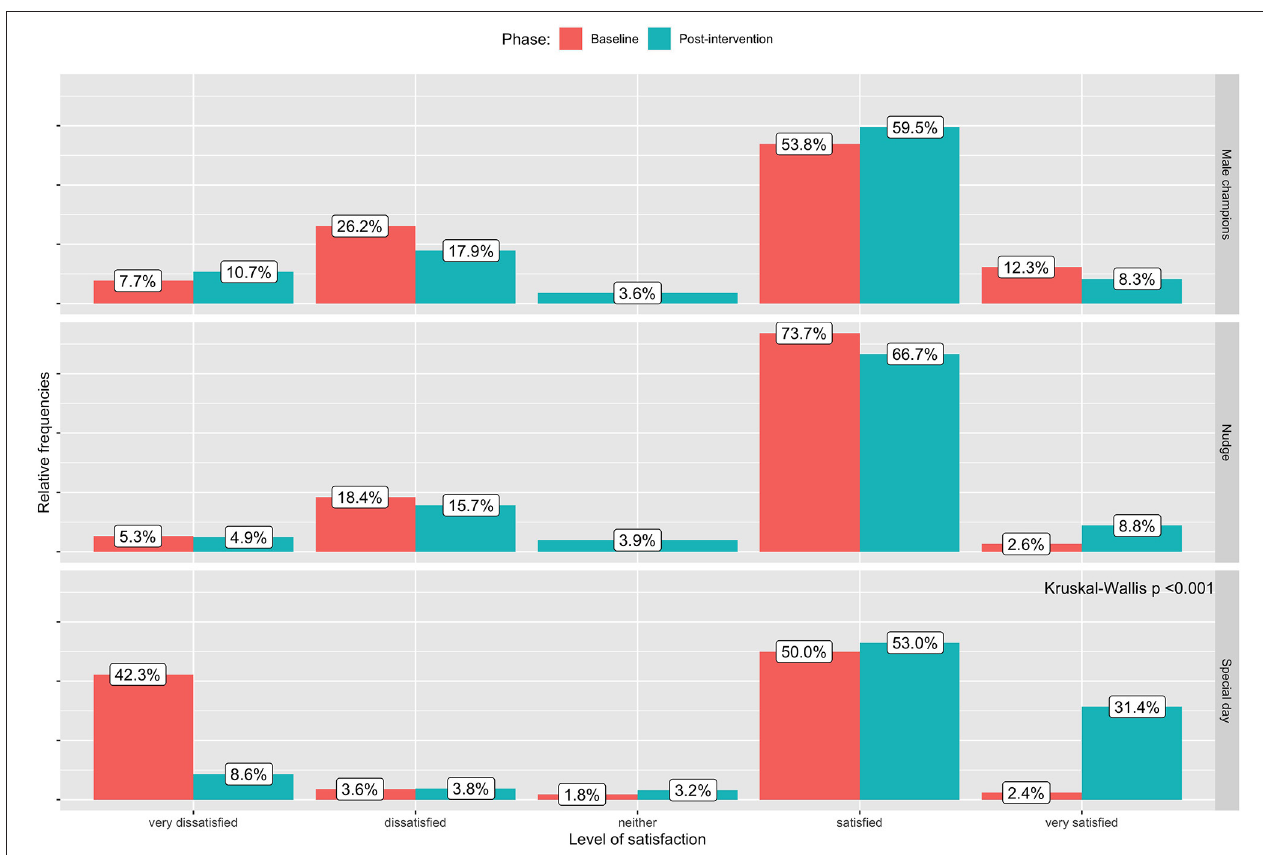
FIGURE 1 | Impact of the interventions on the intermediate outcome (iii): level of satisfaction expressed by women on the support that they are receiving by their male partners at baseline and post-intervention.